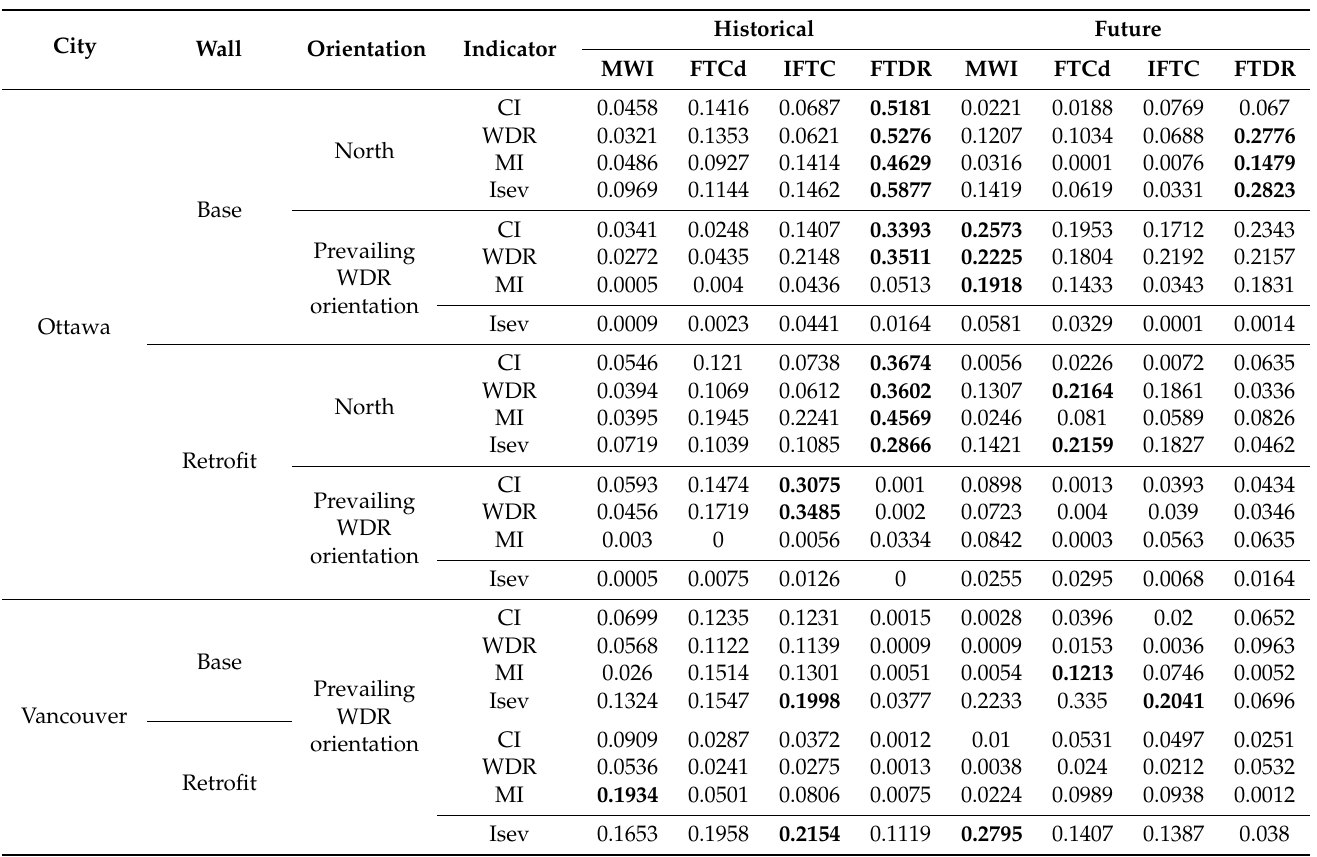
Table 3. Correlation between climate-based and response-based indices for the two orientations N and WDR of each wall: original solid masonry wall (Base wall) and internally retrofitted wall (Retrofit) located in Ottawa and Vancouver. The highest values per index and climate are marked in